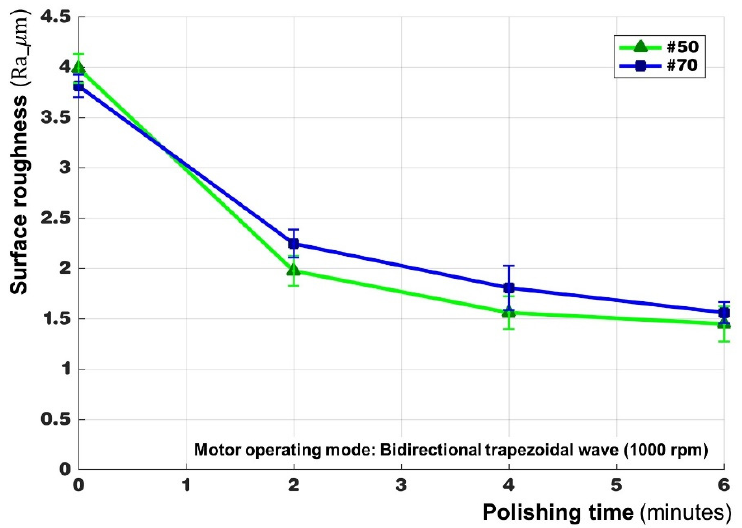
Figure 11. Comparison chart of average surface roughness and polishing time of two kinds of steel particle size.